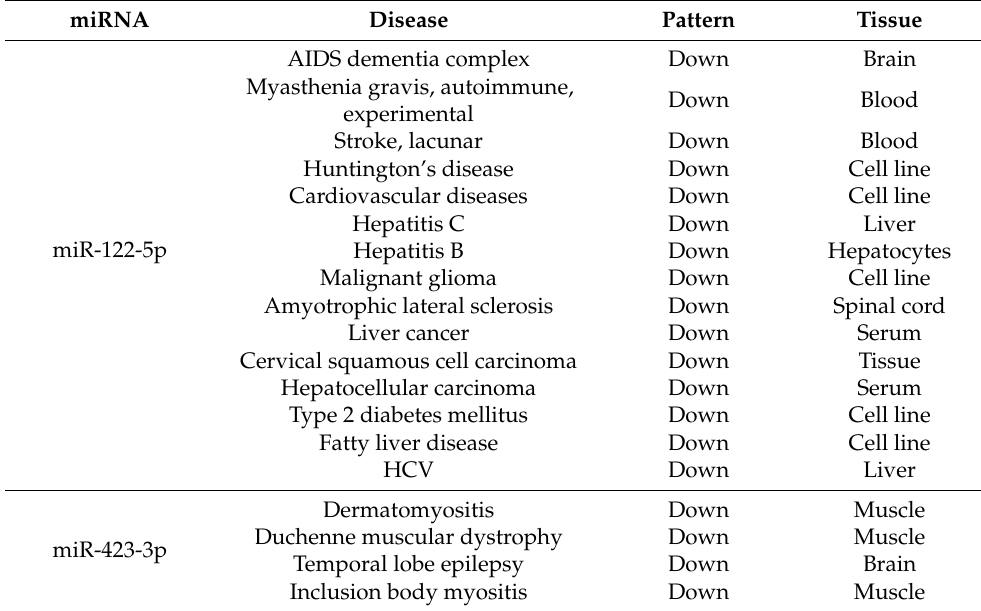
Figure 6. Tissue expression profile of characteristic miRNAs. ( A ) The expression level of up-regulated miRNA in cord venous blood was detected by RT-qPCR. ( B ) The expression level of down-regulated miRNA in cord venous blood was detected by RT-qPCR. ( C – E ) The expression of miR-191-5p ( A ), miR-423-3p ( B ) and miR-122-5p in placenta and piglet tissue (heart, liver, spleen, lung, and kidney). N = 3. * p < 0.05. Table 2. Types of diseases involved in characteristic miRNAs.